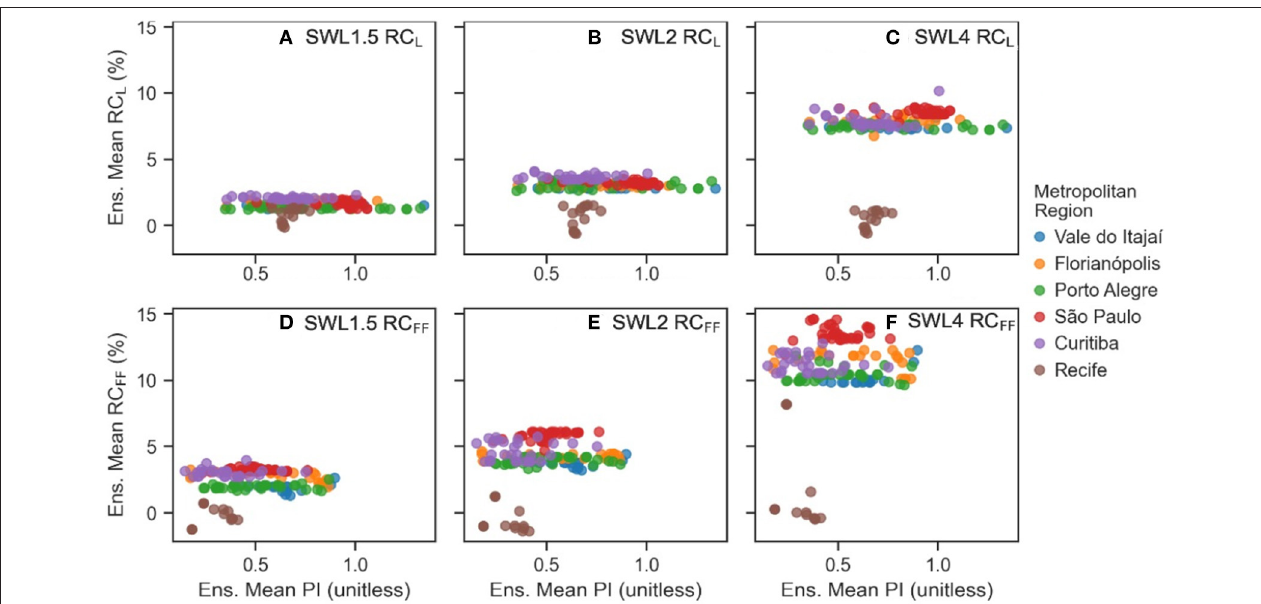
FIGURE 7 | Change of potential impact indices for landslides RC L (A–C) and flash floods RC FF (D–F) for various levels of warming (A) GWL 1.5, (B) 2.0 and (C) 4.0. Changes are for various levels of potential index for landslides (PI L ) and flash floods (PI FF ) for some metropolitan regions of Brazil in the present (Baseline). Each dot represents a municipality located at each metropolitan